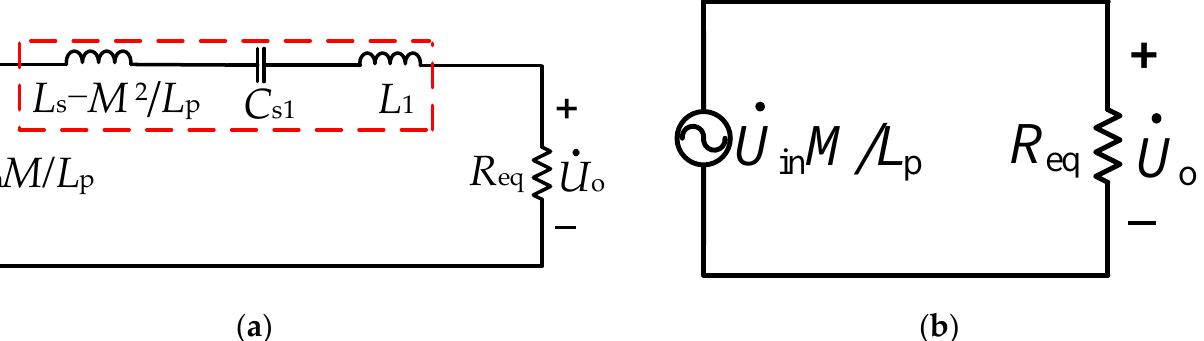
Figure 5. Equivalent model in CC mode. ( a ) Equivalent compensation network; ( b ) Simplified compensation network; ( c ) Equivalent current source model. The equivalent model in constant-voltage mode is shown in Figure 6. Here, output voltage of the compensation network. In this mode, switches S 1 and S 2 are turned off, similarly, when the equivalent inductance L T , L 1 , and C s1 resonate at frequency f . In this case, Figure 6a can be simplified as Figure 6b.